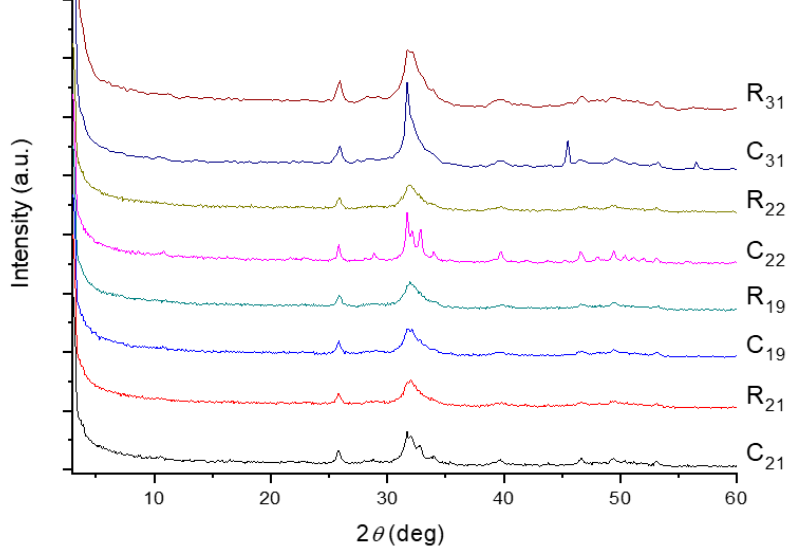
Figure 1. XRD patterns acquired for selected human dentin samples. R 21 and C 21 denote dentin extracted from the root and the crown, respectively, of the third molar of a 21-year-old dental patient.